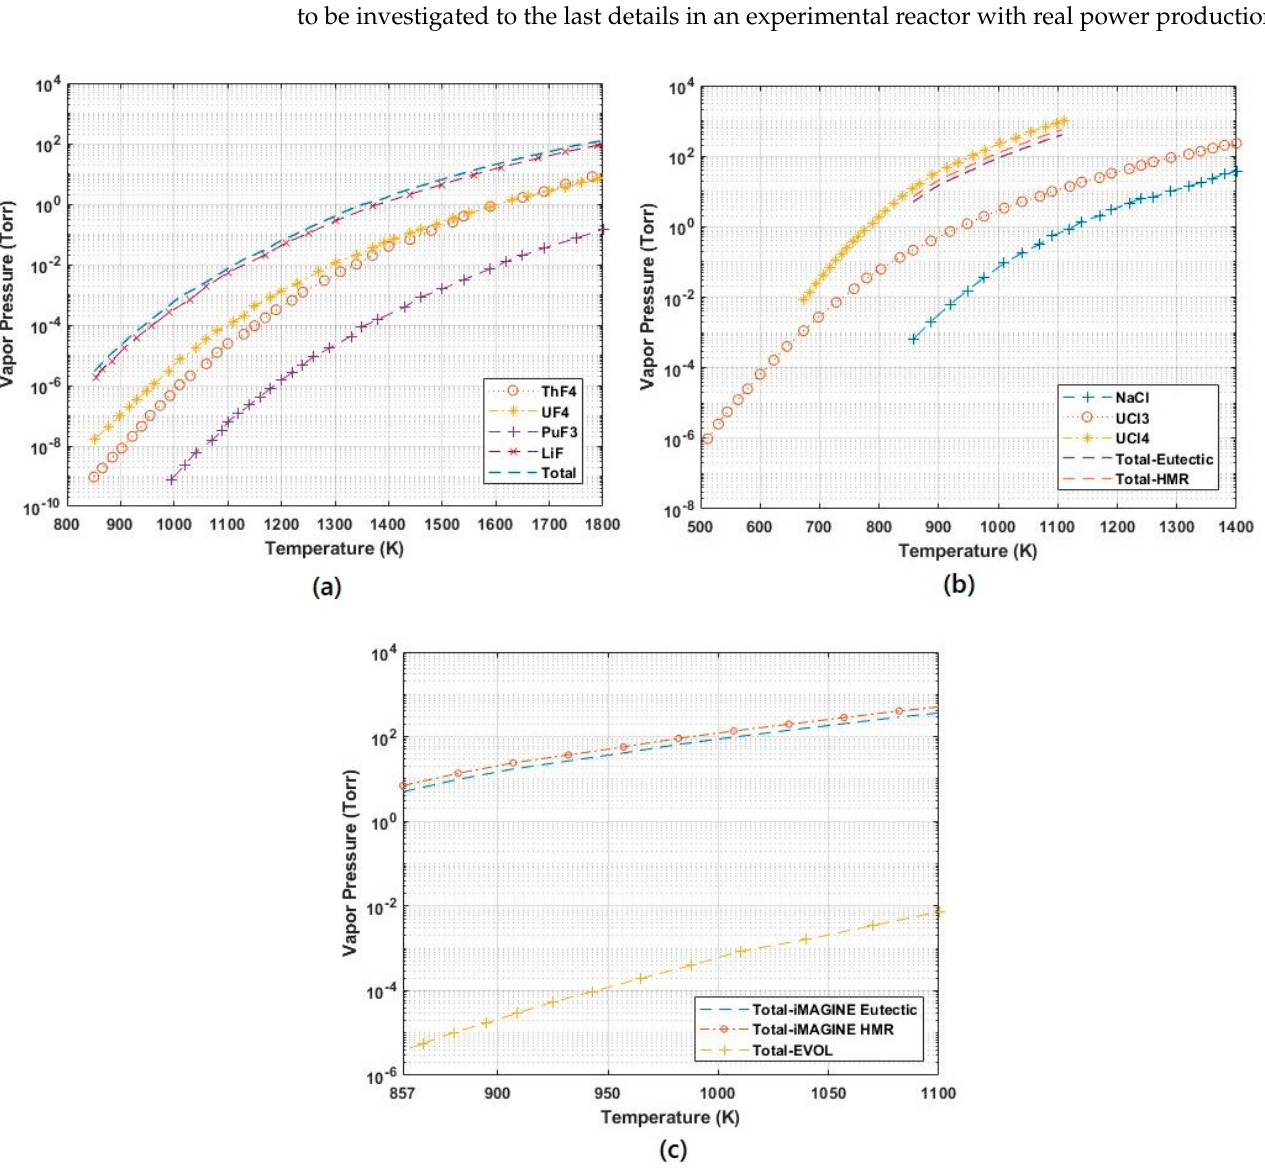
Figure 3. Total and components vapour pressure of salt fuel system for ( a ) EVOL, ( b ) iMAGINE and ( c ) comparison between EVOL and iMAGINE project in the range of 857–1100 K.